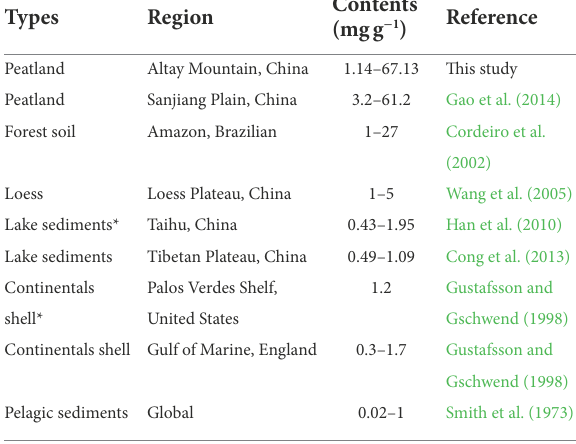
TABLE 1 The black carbon contents (mg g − 1 ) for different deposition archives.